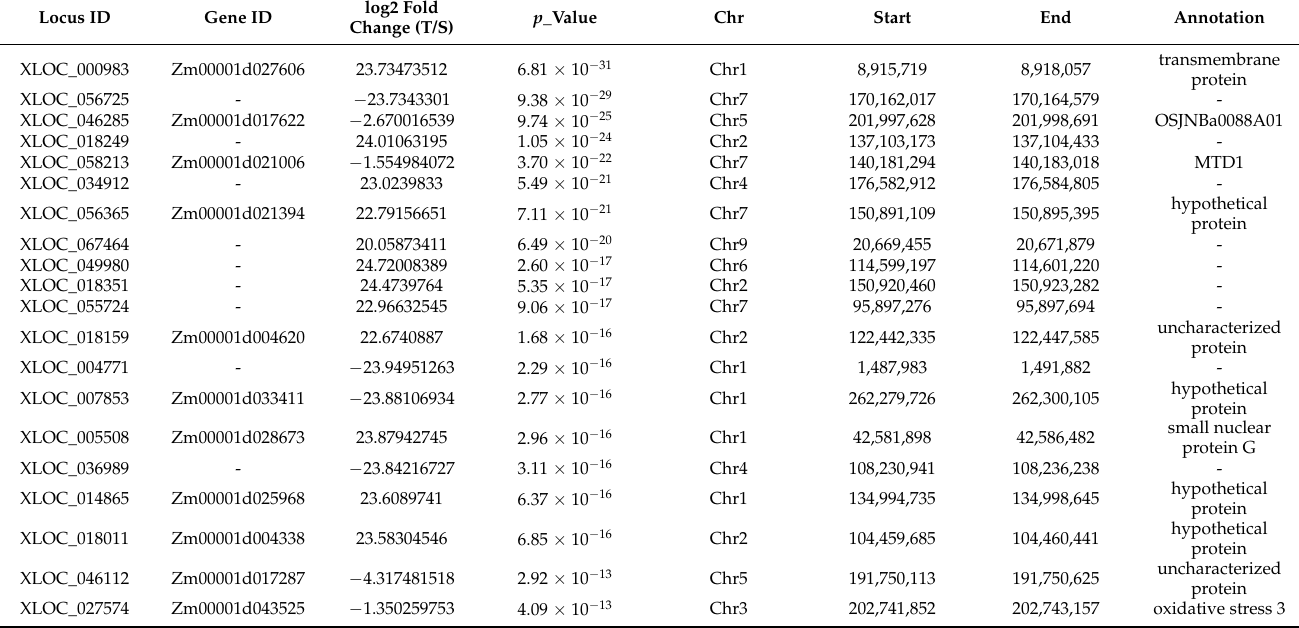
Table 2. List of top 20 most regulated DEGs by cold stress.